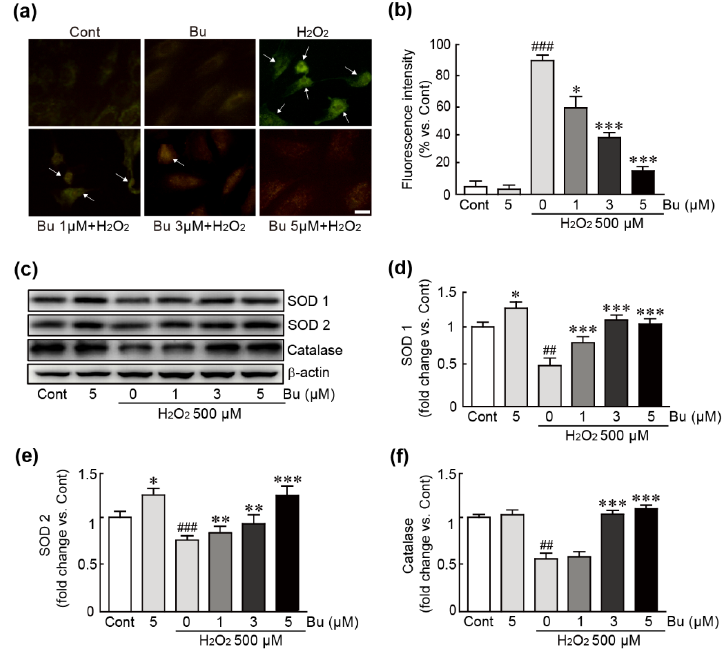
Figure 4. Butein attenuates oxidative stress responses in H 2 O 2 -treated H9c2 cardiomyoblasts. Intra- cellular ROS production was assessed by a DCFH-DA staining ( a ) and the measurement of green fluorescence intensity ( b ) using cells treated with butein and/or H 2 O 2 . The arrow indicates the cells in which ROS accumulated. ( c ) Western blot analysis for the expression levels of antioxidants in- cluding SOD1, SOD2, catalase, and β -actin (loading control). The band densities of SOD1 ( d ), SOD2 ( e ), and catalase ( f ) proteins were calculated with HD imaging software. The results are shown as the mean ± SEM in triplicate. ## p < 0.01 and ### p < 0.001 vs. control group. * p < 0.05, ** p < 0.01, and *** p < 0.001 vs. H 2 O 2 -only group. Cont; control, Bu; butein. Scale bar, 100 µm. 3.5. Butein Attenuates Oxidative-Stress-Induced Mitochondrial Superoxide Production and Dysfunction in H9c2 Cardiomyoblasts To elucidate whether butein could prevent mitochondrial superoxide production and dysfunction caused by H 2 O 2 -induced oxidative stress, mtSOX Red staining was per- formed to detect mitochondrial superoxide in cells treated with butein and/or H 2 O 2 . The results showed that H 2 O 2 -only treatment dramatically induced red fluorescence, indicat- ing that mitochondrial superoxide had accumulated (78.7% increase in red fluorescence intensity compared with control cells) (Figure 5a,b). In contrast, lower levels of red fluo- rescence were observed in butein-pretreated/H 2 O 2 -treated cells (67.1%, 38.6%, and 14.6% increases in 1, 3, and 5 µM butein-pretreated cells, respectively compared with the H 2 O 2 - only treated cells) (Figure 5a,b). Similarly, Western blot analysis against mitochondrial complex II protein as a typical mitochondrial structural protein showed that the expres- sion level of this protein was decreased in H 2 O 2 -only-treated cells; otherwise, butein pre- treatment preserved the expression of this protein (0.4-fold change in H 2 O 2 -only-treated cells vs. controls and 0.6-, 0.9-, and 1.2-fold changes in 1, 3, and 5 µM butein-pretreated cells, respectively, vs. H 2 O 2 -only-treated cells) (Figure 5c,d). Collectively, these results